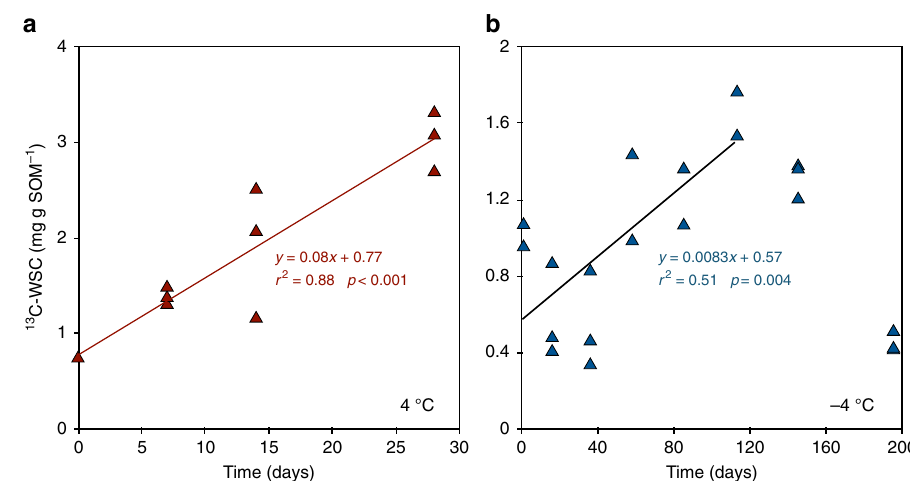
Fig. 4 13 C-labeled water-soluble carbohydrates were form from hydrolysis of the added 13 C-cellulose in both unfrozen and frozen soil samples. Changes with time (and fi tted linear functions, p < 0.005) in concentrations of 13 C-labeled water-soluble carbohydrates ( 13 C-WSC) in the samples incubated at 4 °C (panel a , red triangles) and − 4 °C (panel b , blue